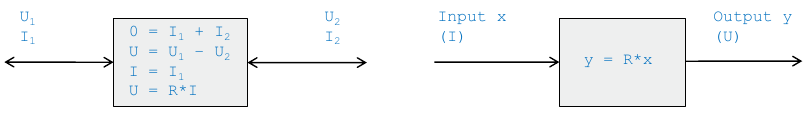
Figure 4. Schematic representation of the equations of an electrical resistance and the signals transferred for modeling with Modelica ( left ) in contrast to Matlab/Simulink ( right ).